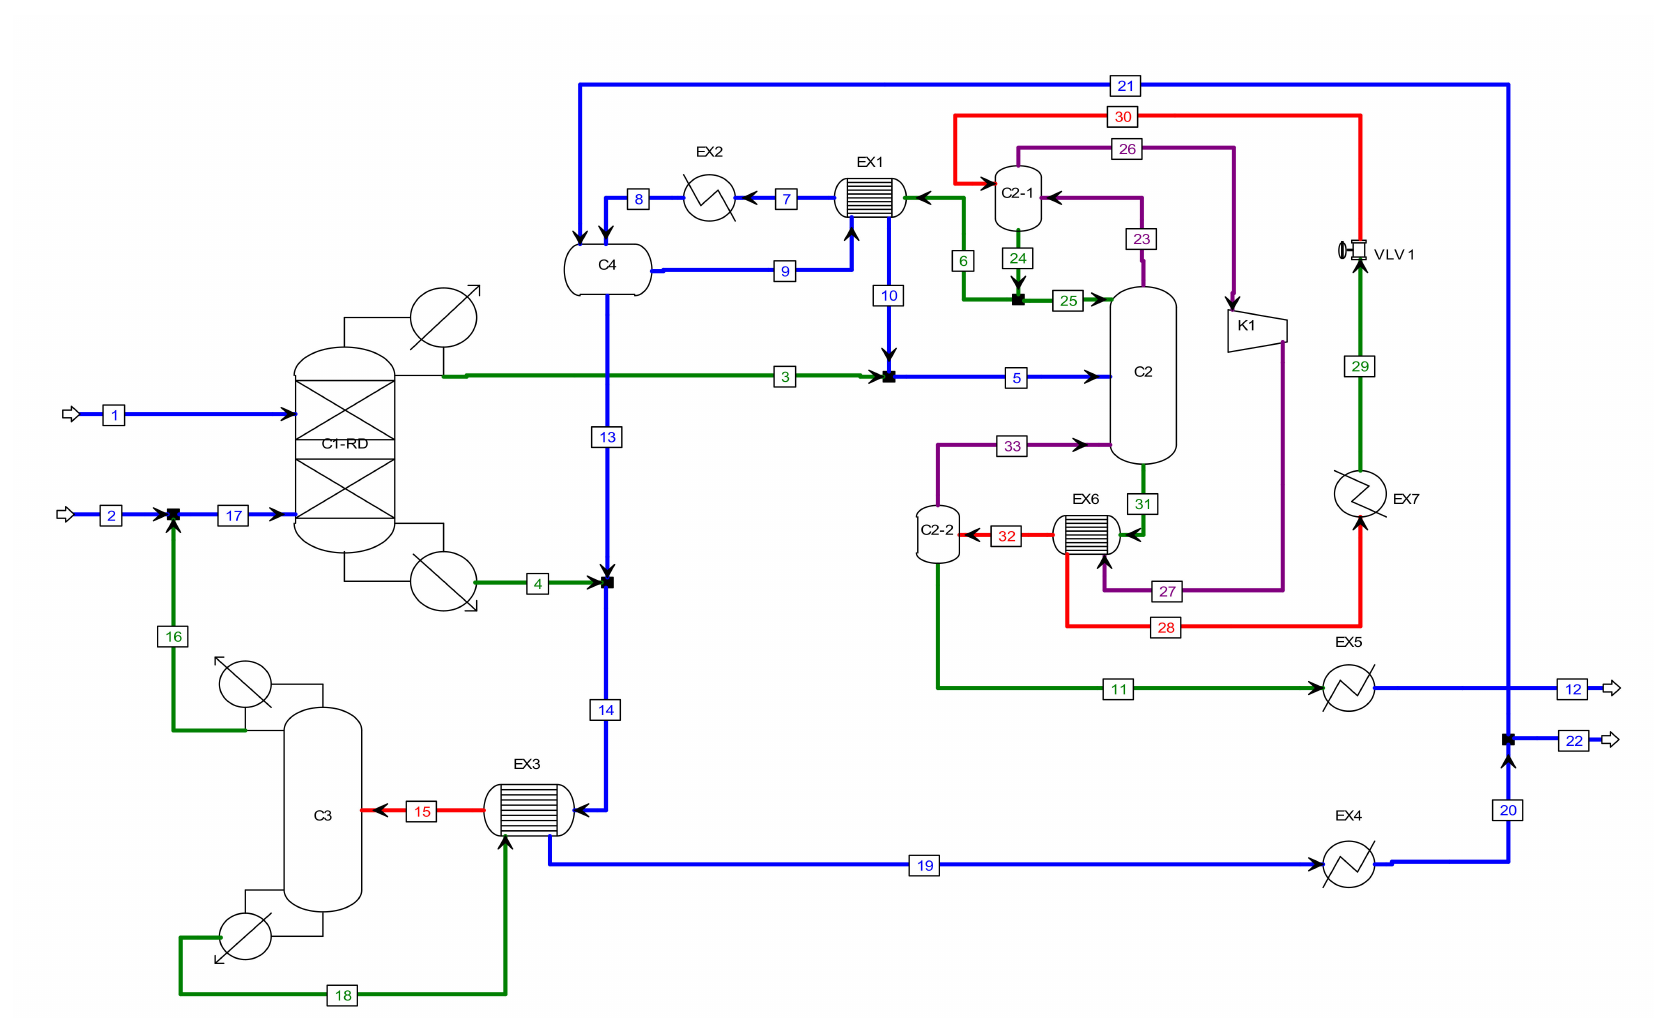
Figure 6. Ethyl acetate production via reactive distillation column with a separation unit and an MVRHP. Stream condition: blue—subcooled liquid; green—liquid at boiling temperature; red—vapor-liquid mixture; purple—saturated/overheated vapor. C1-RD—reactive distillation column; C2, C3—distillation columns; C2-1,2—flash separators; C4—decanter; K1— compressor; EX1-7—heat exchangers; VLV1—throttle